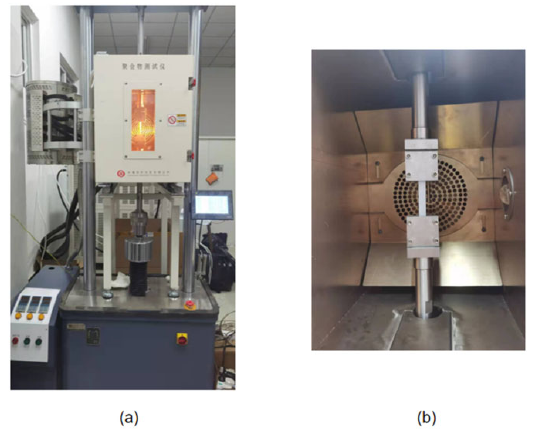
Figure 6. ( a ) Experimental machine. ( b ) Temperature control box.